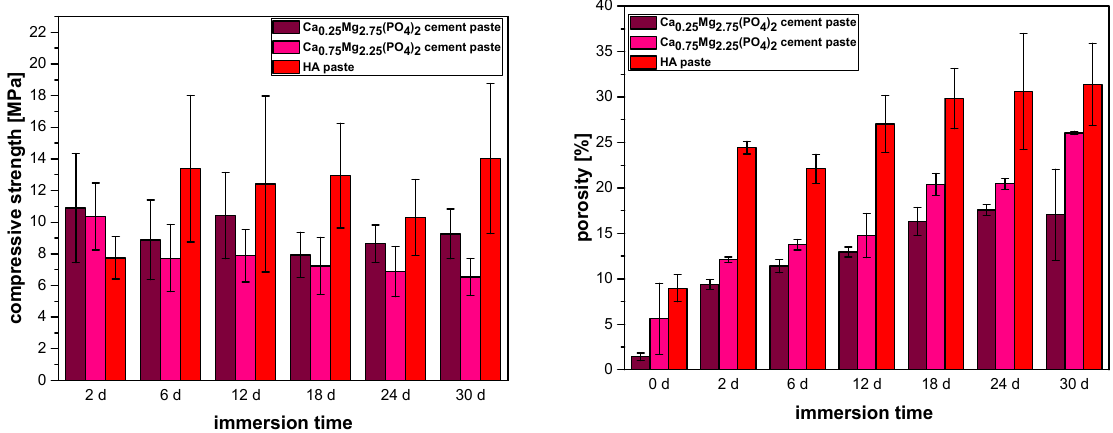
Figure 2. Compressive strength ( left , n = 9) and porosity (right , n = 3) of samples prepared from premixed CaMgP and HA forming cement pastes during incubation in PBS for 30 d at 37 °C.